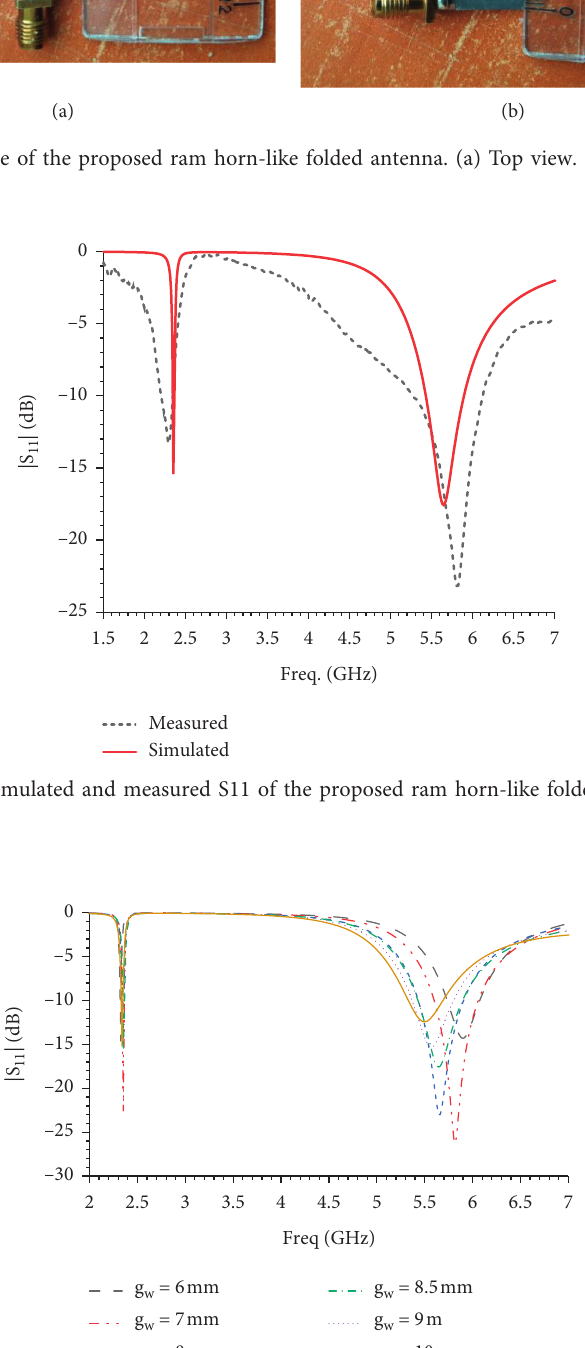
11 variation due to